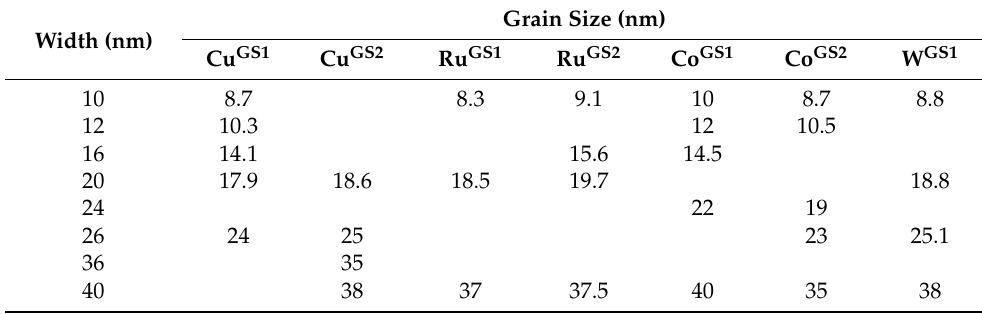
Table 3. Extracted grain sizes for Cu, Ru, Co, and W from experimental